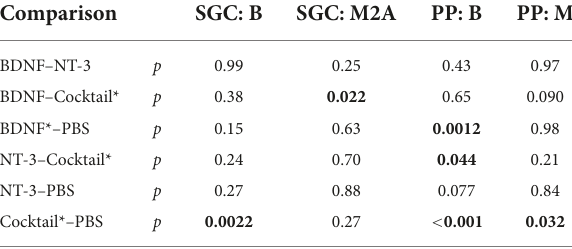
TABLE 2 P -values from Tukey’s pairwise comparison following the ANOVA as post hoc of the linear mixed model, performed on the normalized packing densities of both SGCs and PPs for the treated